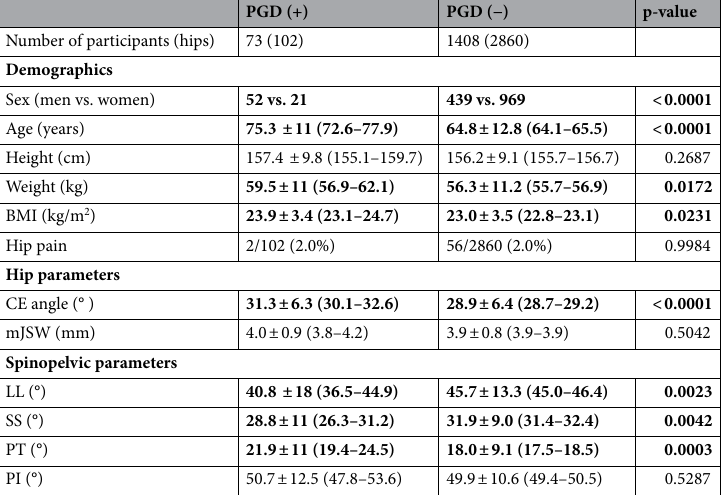
Table 2. Comparison of the demographics between the groups with and without PGD. Prevalence of hip pain and hip parameters are calculated from 2962 hips. PGD pistol grip deformity, BMI body mass index, CE angle center–edge angle, mJSW mean joint space width, LL lumbar lordosis, SS sacral slope, PT pelvic tilt, PI pelvic incidence. Data are means ± standard deviation (95% confidence interval). Bold values indicate statistically significant differences between the two